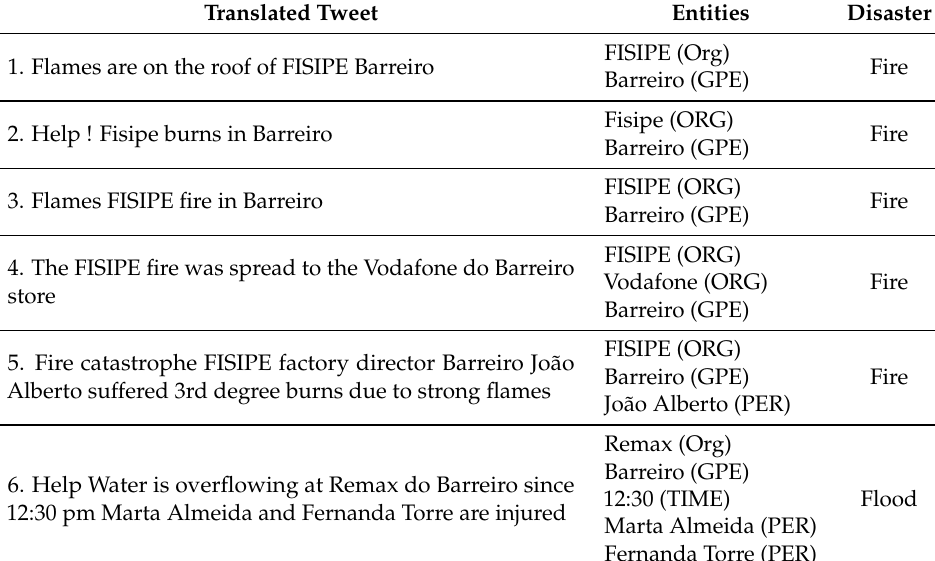
Table 4. Processed tweets and extracted